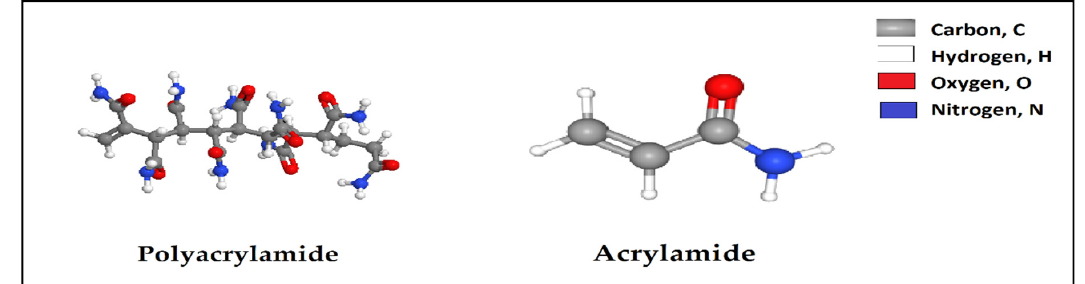
Figure 10. The chemical structure of polyacrylamide and acrylamide.